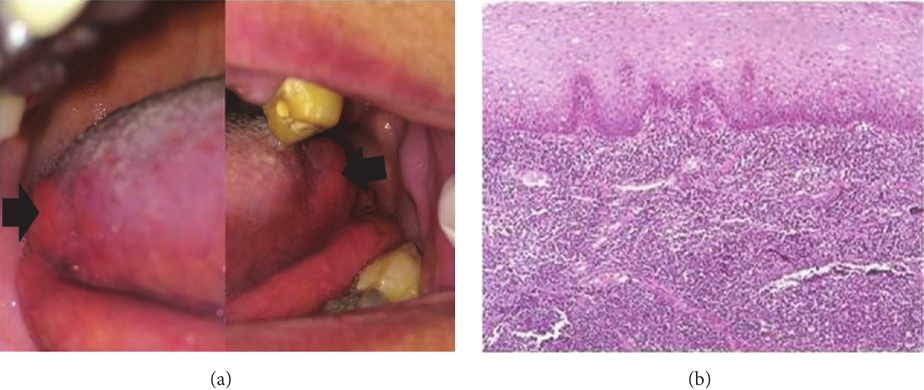
Figure 3: (a) Clinical aspect of bilateral lymphoid hyperplasia in relation to the posterior part of lateral border of the tongue. (b) Photomicrograph of lymphoid hyperplasia showing lymphocytic proliferation in subepithelial and deep connective tissue (H&E × 100).